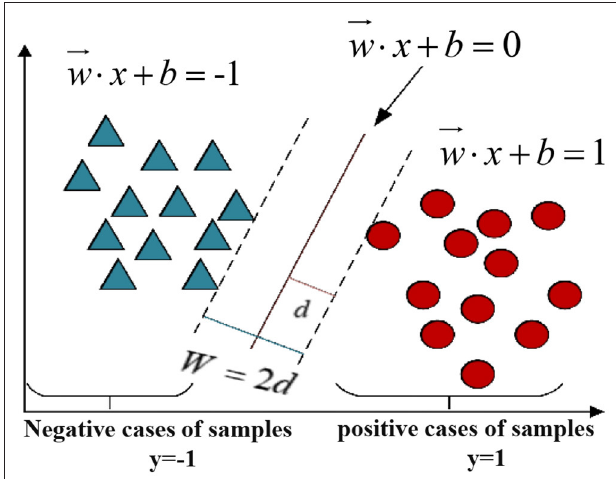
FIGURE 4 | SVM classification model